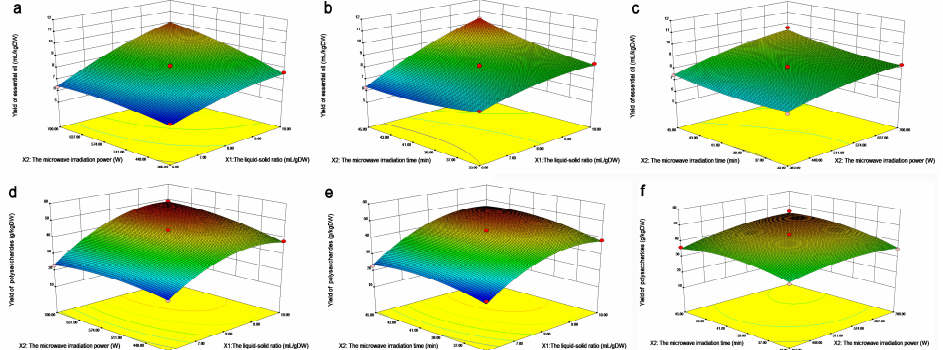
Figure 7. Response surface diagram of the influence of various factors on the yield of EO; ( a ) The influence of microwave power and liquid-solid ratio on the extraction rate of EO; ( b ) The influence of microwave time and liquid-solid ratio on the extraction rate of EO; ( c ) The influence of microwave time and microwave power on the extraction rate of EO; ( d ) The influence of microwave power and liquid-solid ratio on the extraction yield of polysaccharides; ( e ) The influence of microwave time and liquid-solid ratio on the extraction yield of polysaccharides; ( f ) Effects of microwave time and microwave power on the extraction yield of